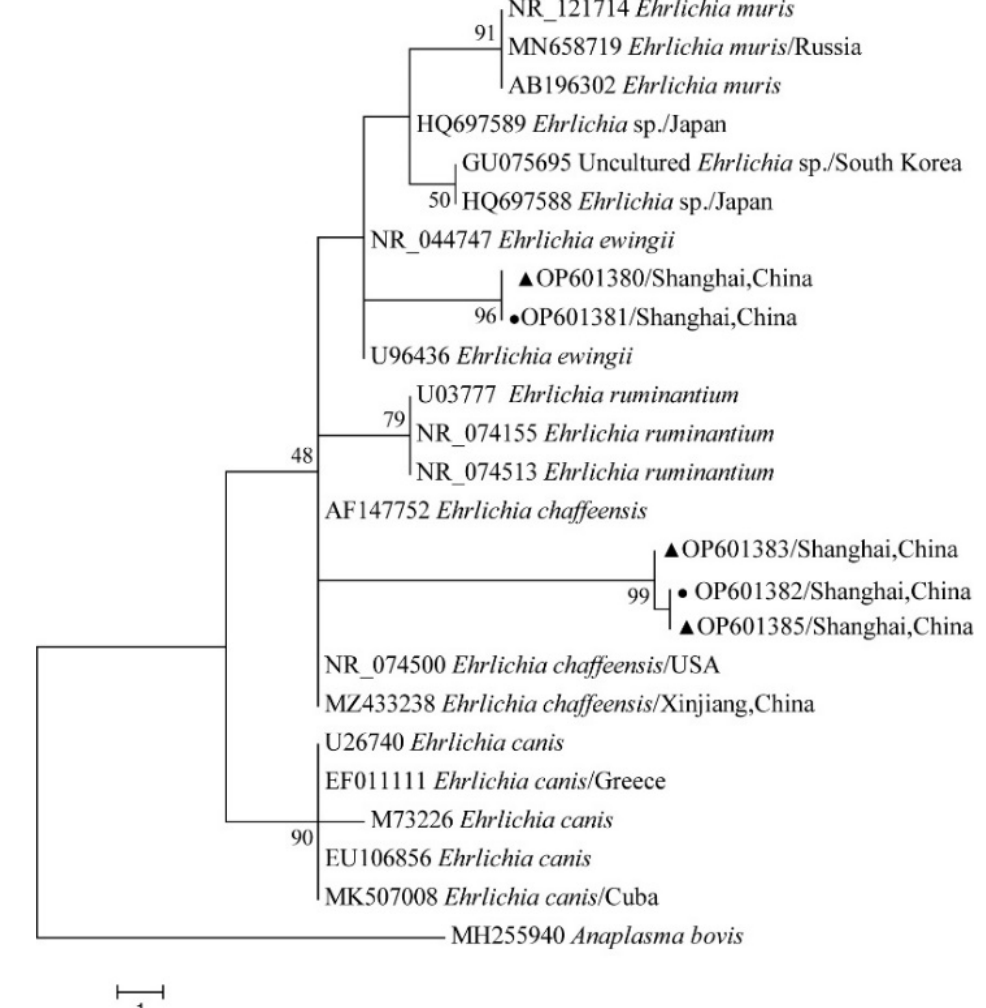
Figure 12. Phylogenetic tree of Ehrlichia spp. in ticks based on partial 16S rDNA gene sequence similarity. The sequence from H. flava obtained in this study is indicated with a black triangle, and the sequence from H. longicornis obtained in this study is indicated with black dots. Sequences were aligned by using the MEGA X (version 10.0) software package. Phylogenetic analysis was performed by the neighbor-joining method (NJ method), and bootstrap values were estimated for 1000 replicates. The Kimura two-parameter model was used as a substitution model for the calculation of the phylogenetic